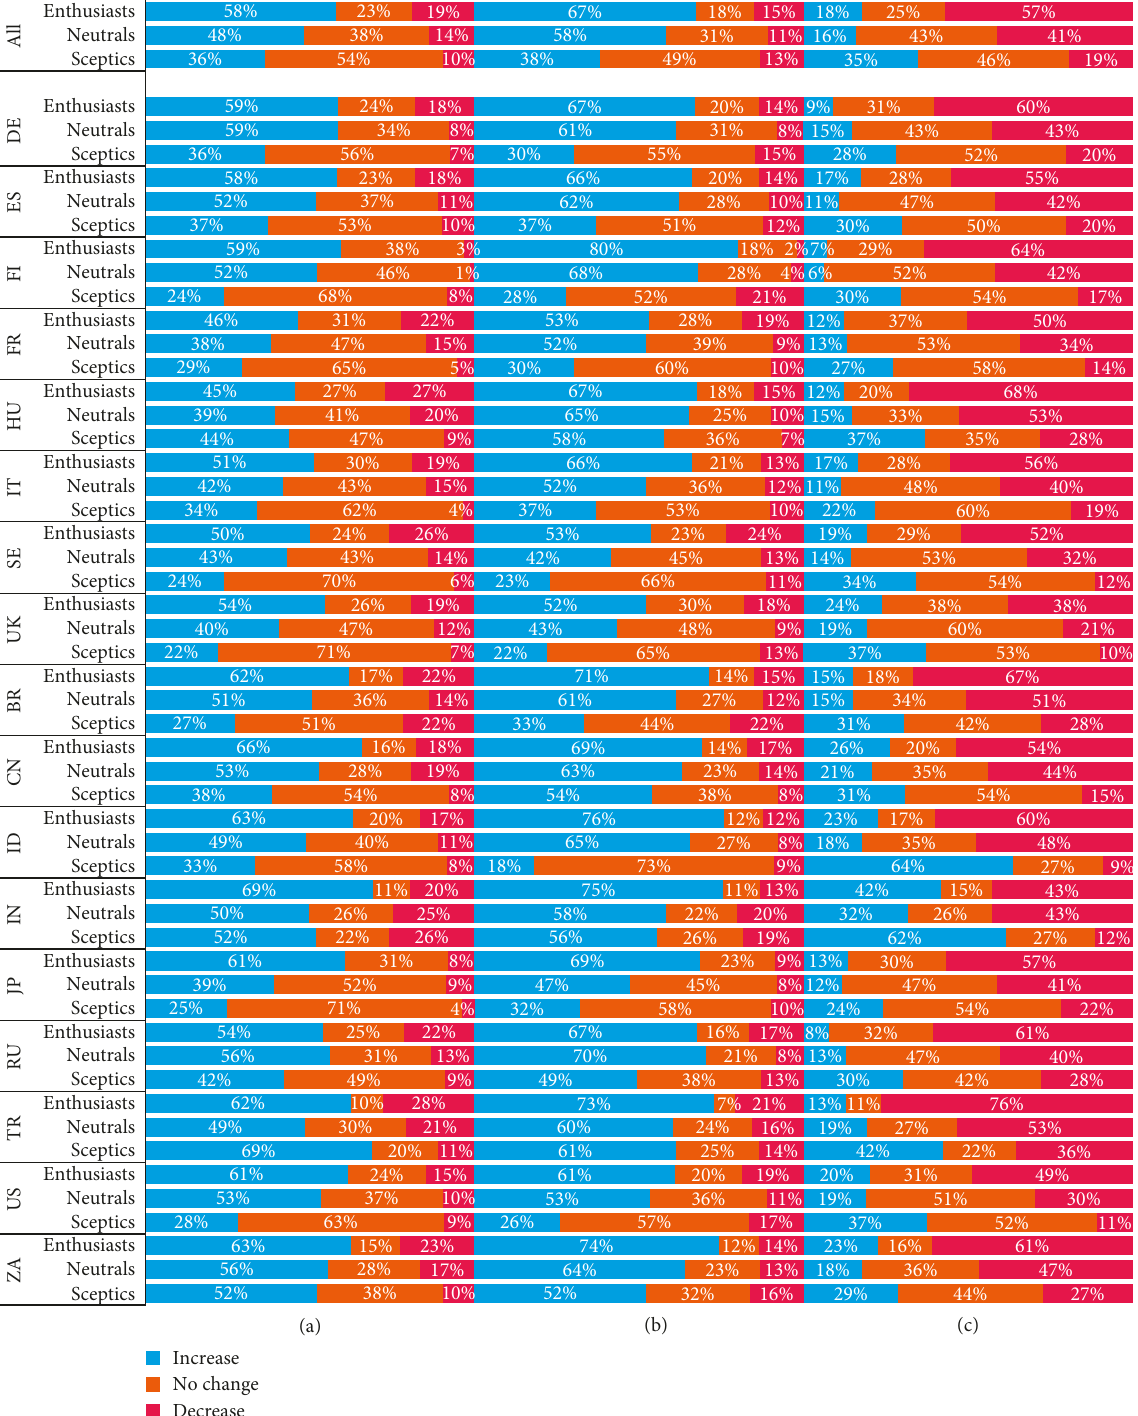
Figure 6: (a) Percentage values of Enthusiasts, Neutrals, and Peptics differing in their expectation about the changes in the productive use of travel time due to conditionally automated cars (Q21.1). (b) Percentage values of Enthusiasts, Neutrals, and Sceptics differing in their expectation about the changes in travel comfort due to conditionally automated cars (Q21.2). (c) Percentage values of Enthusiasts, Neutrals, and Sceptics differing in their expectation about the changes in the number of traffic accidents due to conditionally automated cars